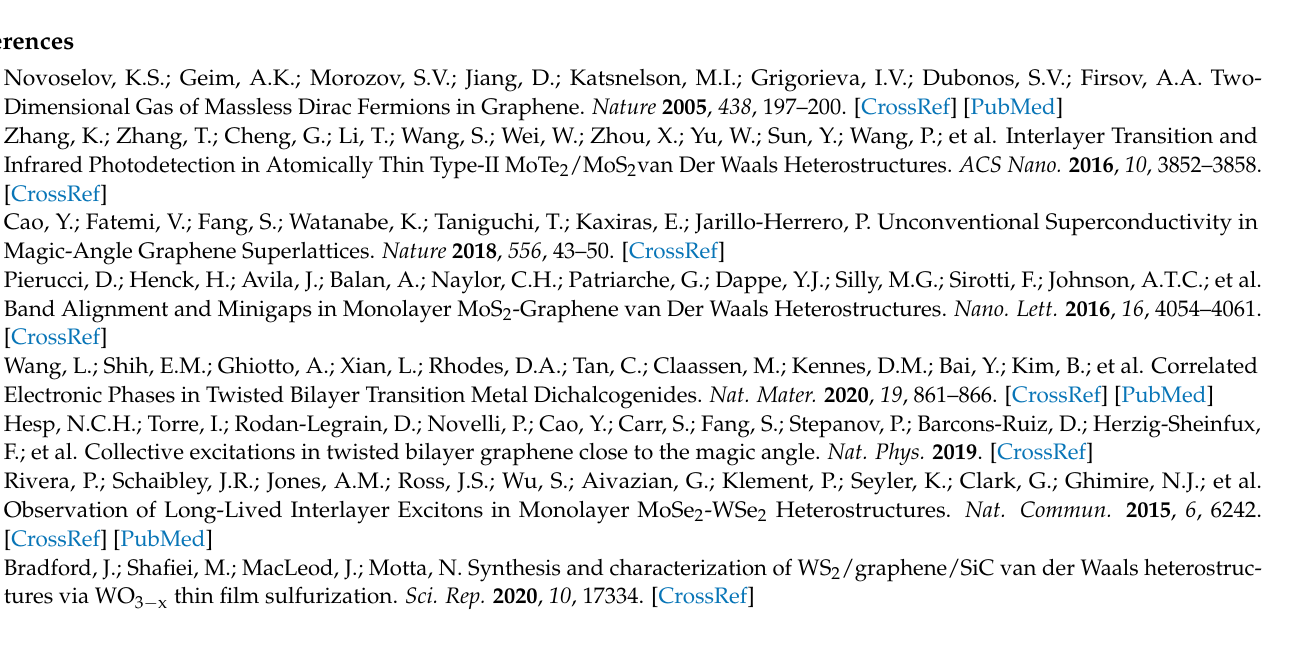
symbols represent the evolution of the Q points. (c) Distance between k θ Figure S3: Evolution of the band-structure calculations of the monolayer WS 2 under strain, Figure S4: Evolution of the band-structure calculations of the monolayer WS 2 under